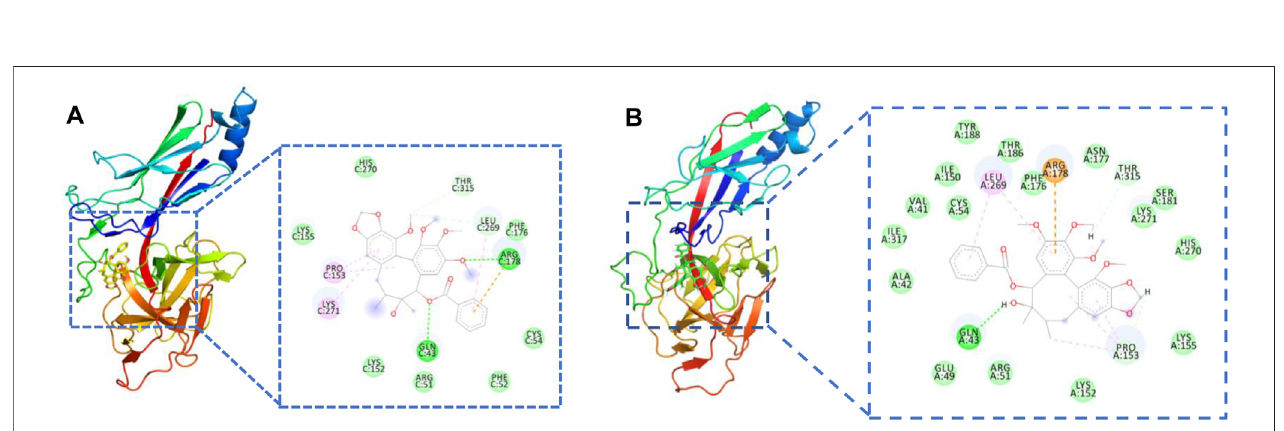
FIGURE8| Molecular interactionsbetween schisantherinAand thekeyresidues ofRBP- κ B. (A) Molecular docking. (B) Themolecularinteractions after molecular dynamics simulations.